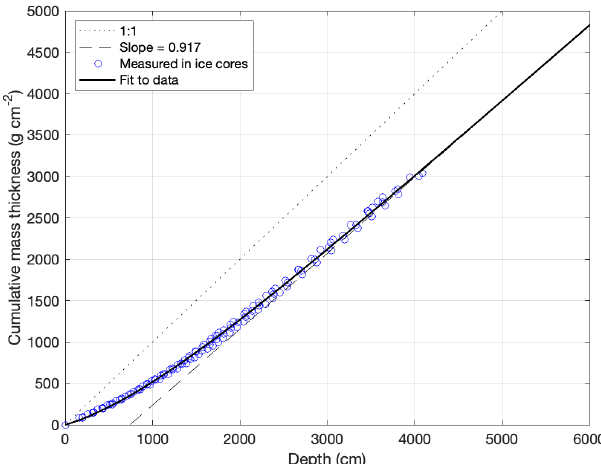
Figure 8. Relationship between linear thickness and mass thickness for ice and firn at Kay Peak core sites. Blue circles are observed cumulative mass thickness derived from downcore measurements of firn and ice density at all core sites. The solid black line is Eq. (1) with fitted values of D and L